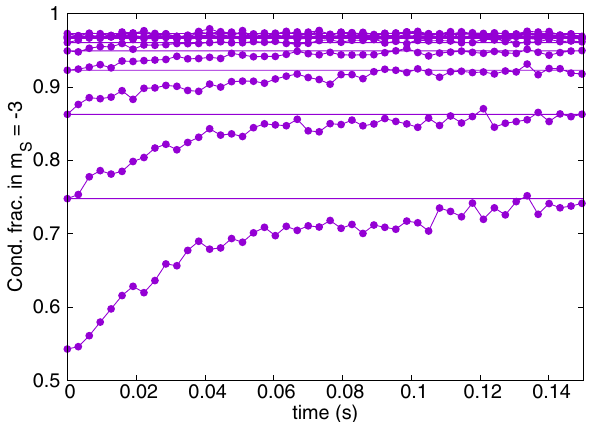
3 , similarly to Fig. 1. Here, magnetic fields were chosen Figure 2. Condensate fraction of 52 Cr gas in m s = − 1 k B T cycle , with T cycle determined by the value of condensed fraction at the according to the rule: 2 µ B B 3 = beginning of a cycle. The initial magnetic field was 0.58 mG.